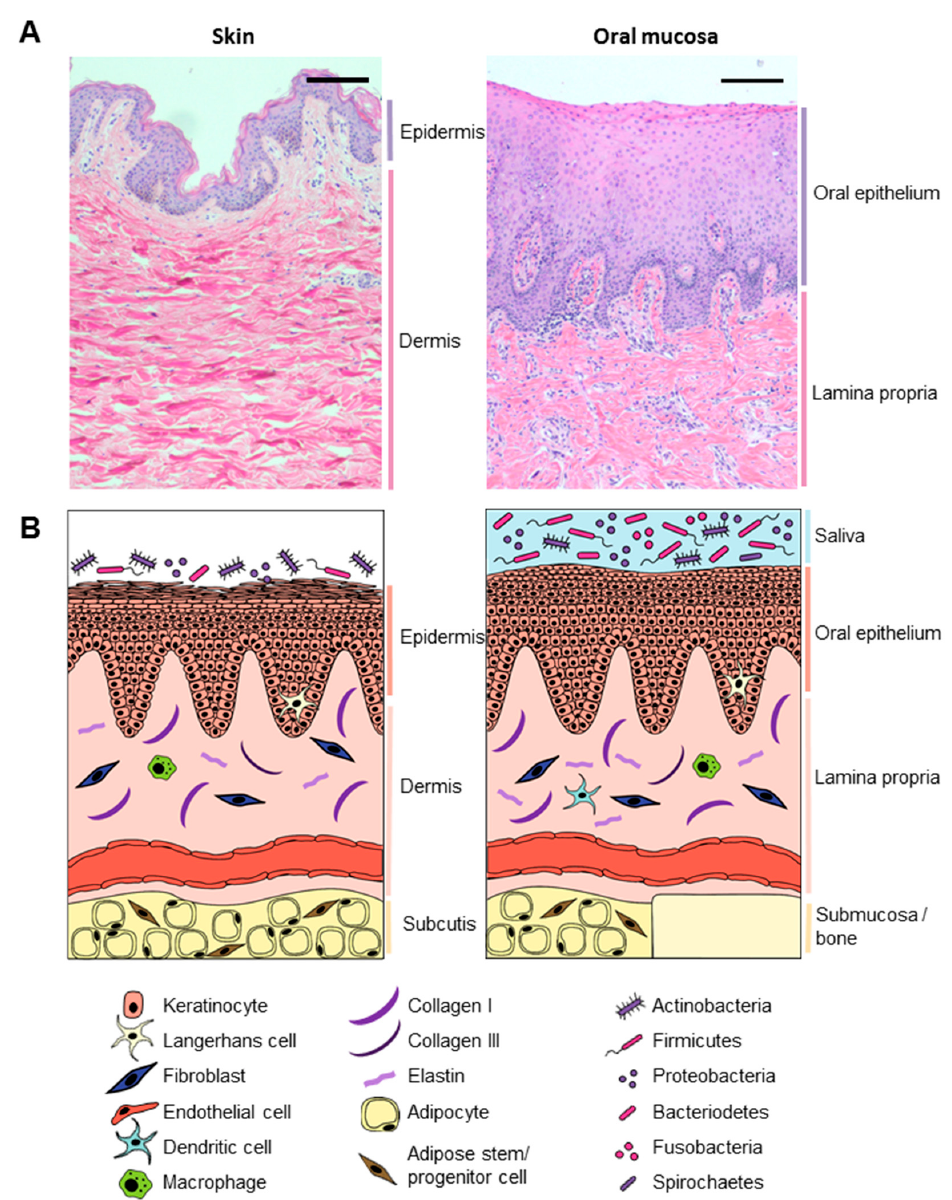
Figure 2. Comparing healthy skin and oral mucosa. ( A ) Histological comparison between healthy skin ( left ) and gingiva ( right ) tissue. Hematoxylin and eosin staining of 5 µm paraffin embedded tissue sections. Scale bar: 100 µm; ( B ) graphical illustration comparing skin ( left ) and oral mucosa ( right ).